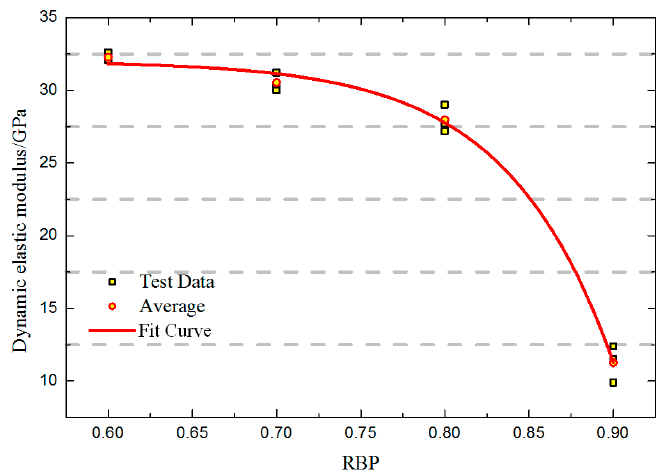
Figure 6. Relation curve of the dynamic elastic modulus and RBP.